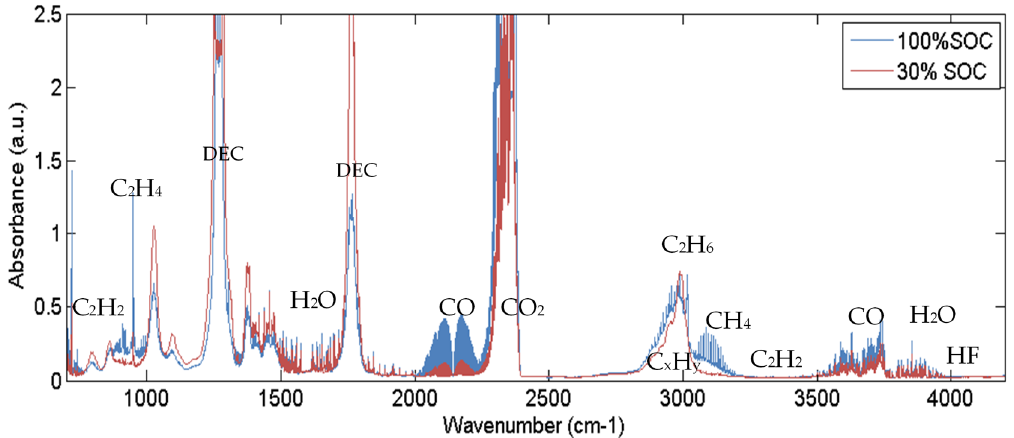
Figure 11. FTIR spectrum of the gas composition measured after the TR of the 100% SOC cell (blue) in comparison to the spectrum measured after stopping the heat ramp at the 30% SOC cell (red).